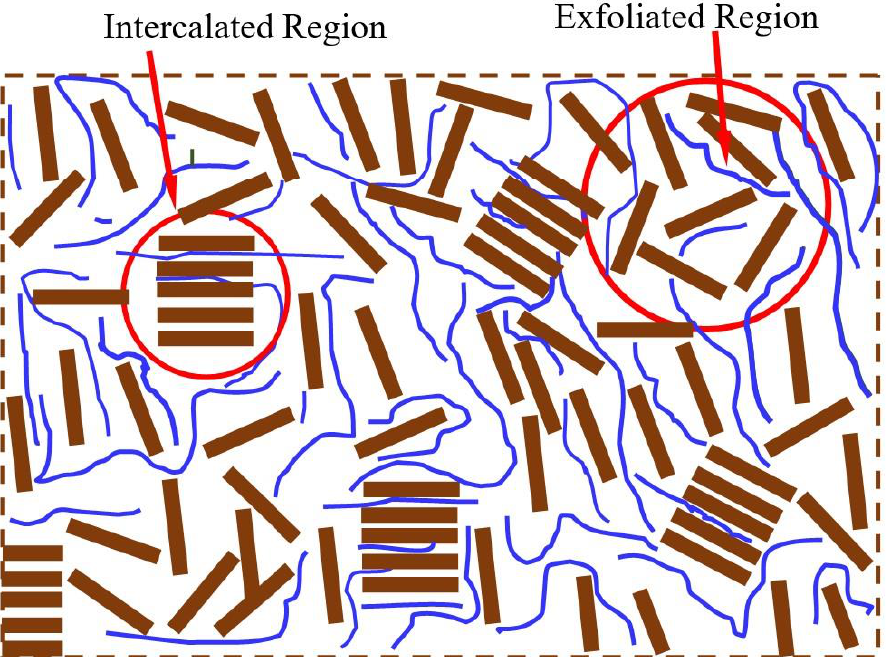
Figure 4. Schematic of a polymer nanoclay composite (PNC) reinforced with randomly distributed intercalated and fully exfoliated clay particles.